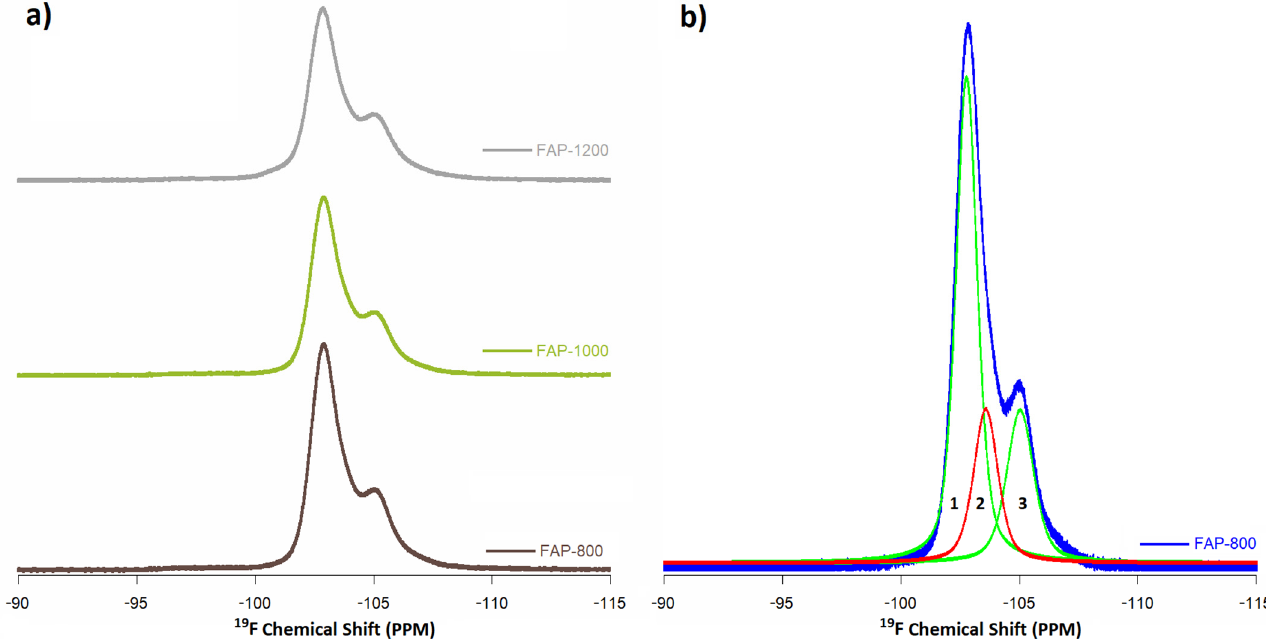
Figure 6. 1 H MAS NMR spectra of ( a ) HAP samples and ( b ) F-substituted apatite samples (multiplied 5 × ). 19 F MAS NMR spectra for fluoridated samples were recorded at a spinning frequency